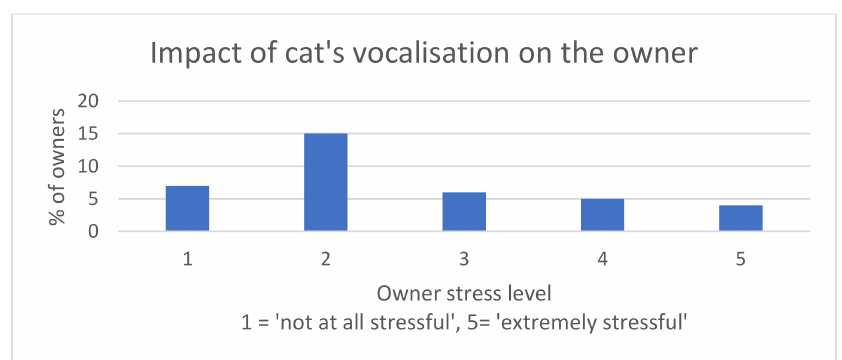
Figure 4. Bar chart summarising the owners’ responses when answering the question of how stressful they found their cat’s excessive vocalisation.